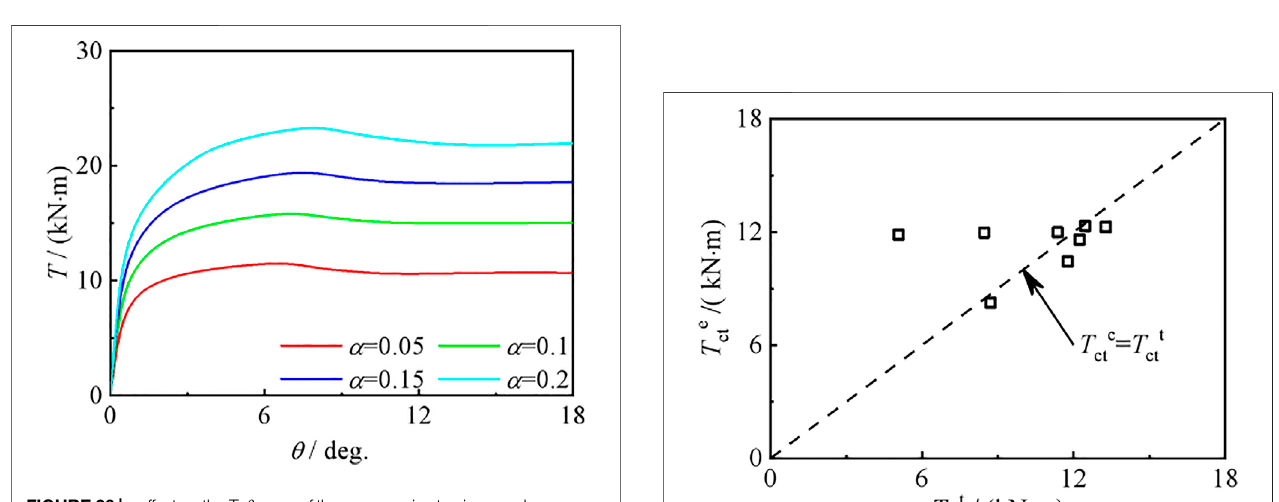
FIGURE 26 | α effectonthe T – θ curveofthecompressiontorsionmember.